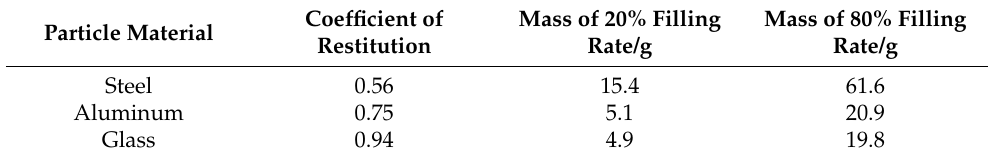
Table 3. Parameters of different particle materials.